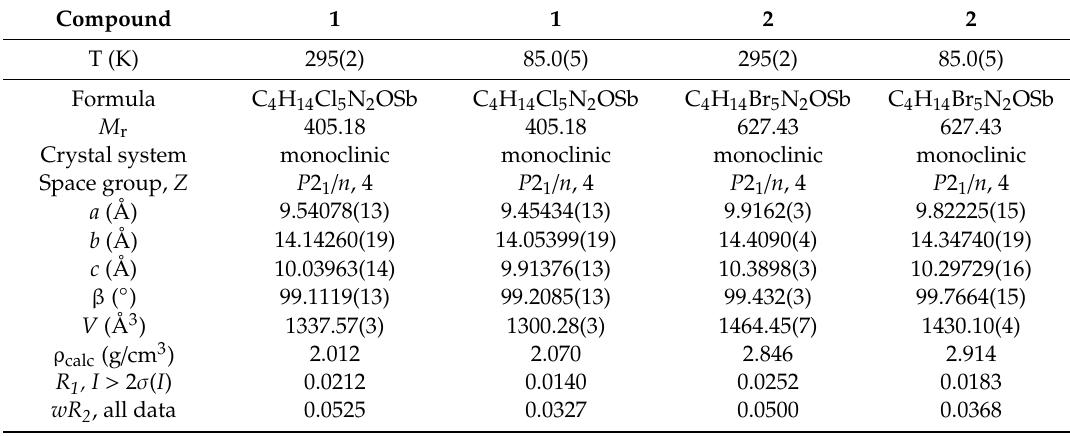
Table 1. Selected crystal data for 1 and 2 at 295 and 85